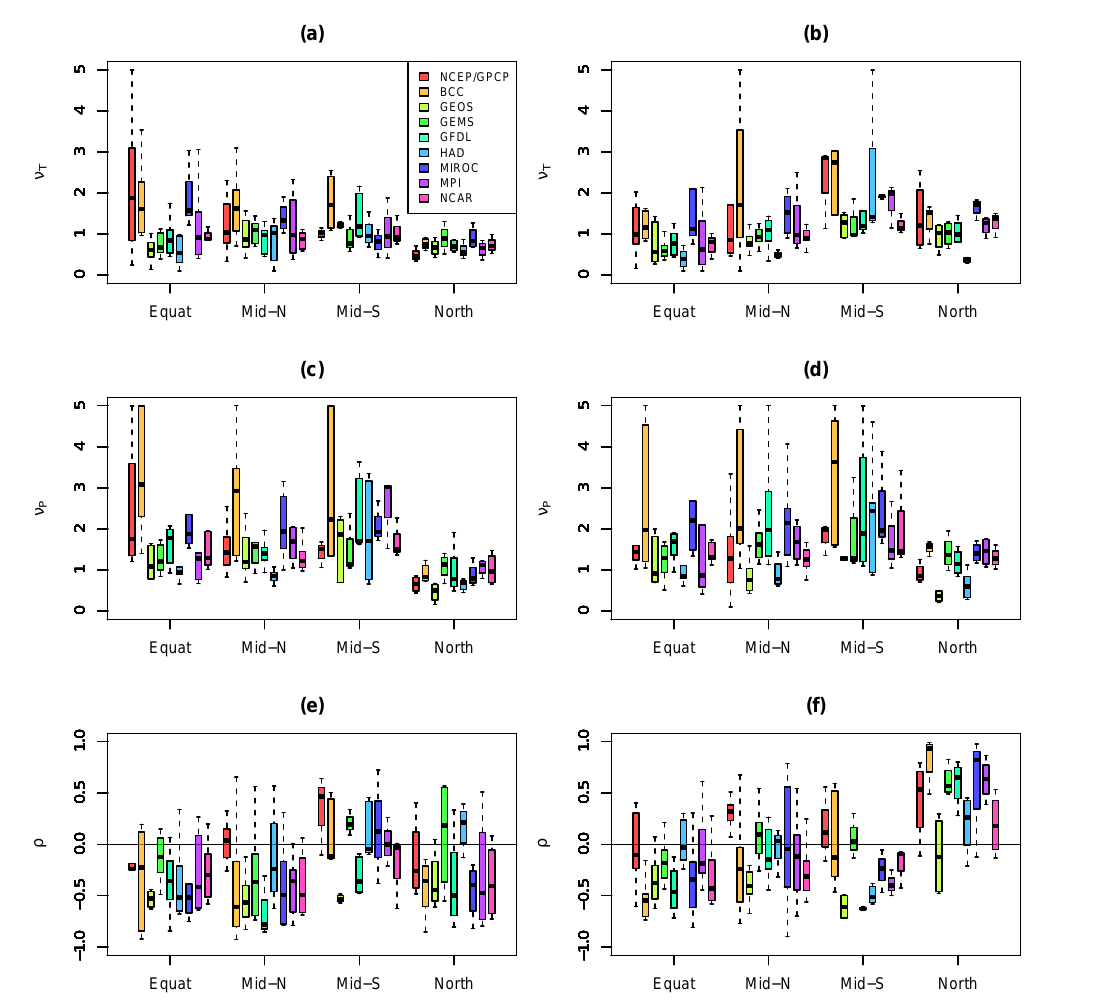
Figure 10. Parameter estimates by source for each season by latitude band, for JJA (left column) and DJF (right column). (a) JJA and (b) DJF for ˆ ν T , (c) JJA and (d) DJF for ˆ ν P , and (e) JJA and (f) DJF for ˆ ρ